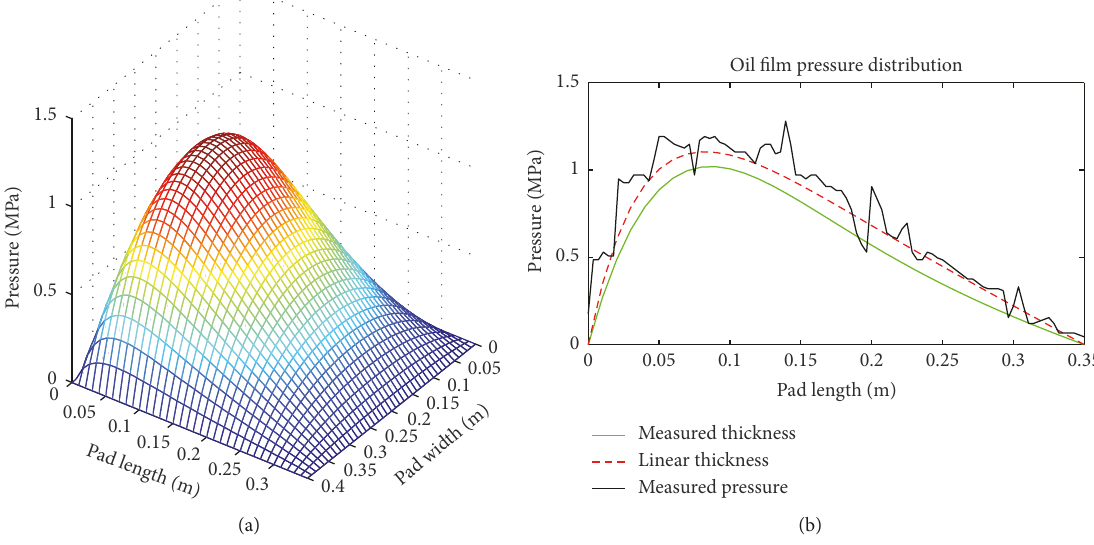
Figure 7: (a) Calculated 3D and (b) comparison between calculated and measured pressure distributions on upper journal bearing, with clearance of 280 𝜇 m and a dynamic viscosity of 0.047 Pas (lubricant at 40 ∘